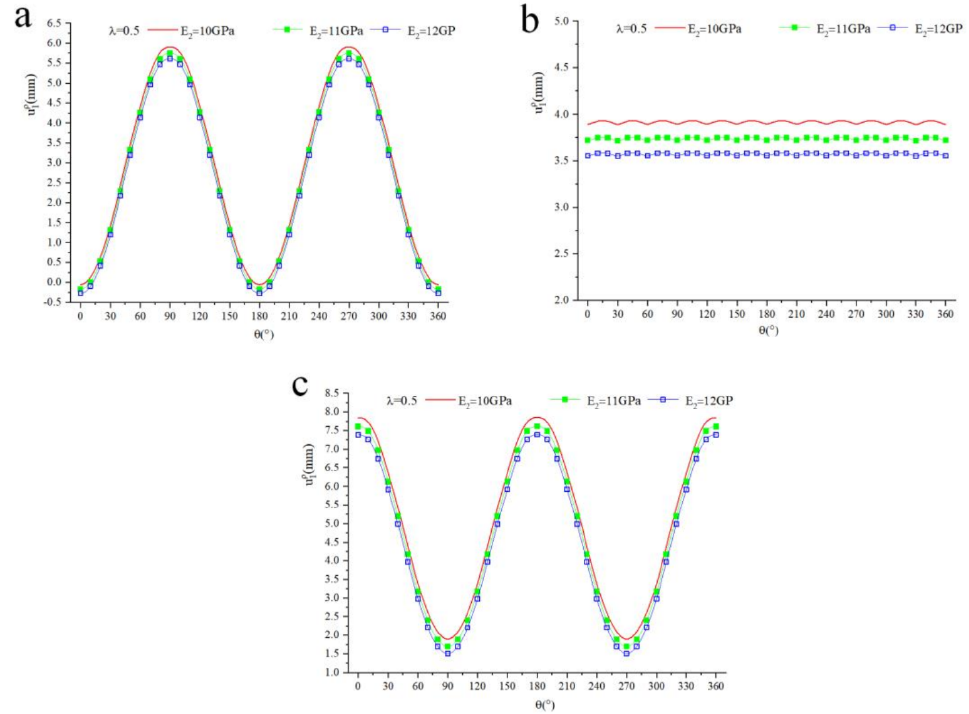
Figure 10. Radial displacement for the points at L − with different E 2 (( a ) λ = 0.5, ( b ) λ = 1.0, ( c ) λ =